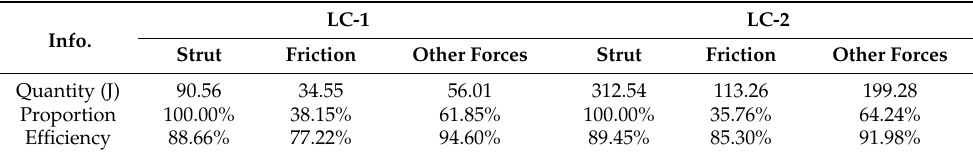
Table 4. Results of energy absorption of elemental